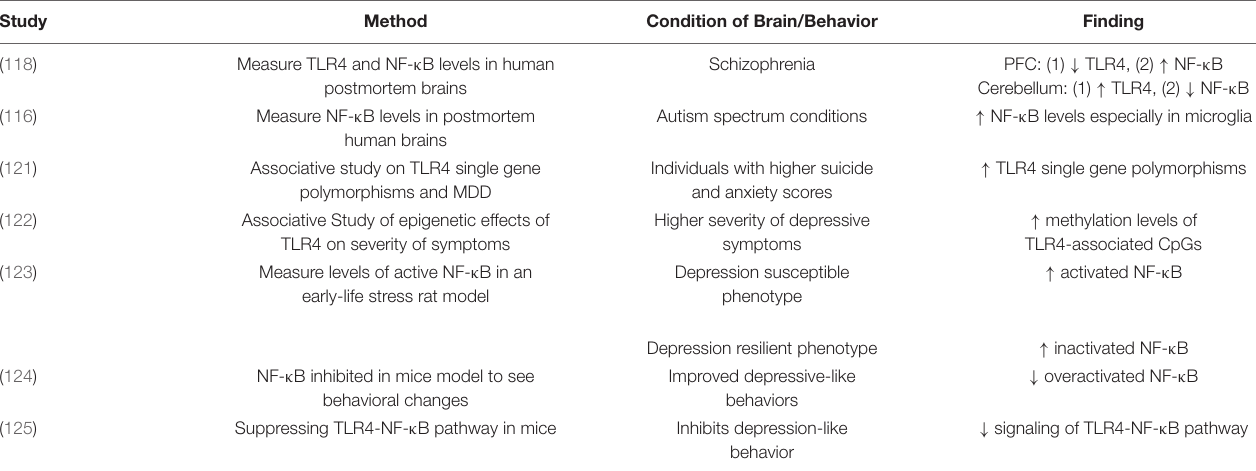
TABLE 2 | Overview of studies performed to investigate TLR4 and NF- κ B’s roles in neuropsychiatric disorders. Study Method Condition of Brain/Behavior (118) Measure TLR4 and NF- κ B levels in human postmortem brains